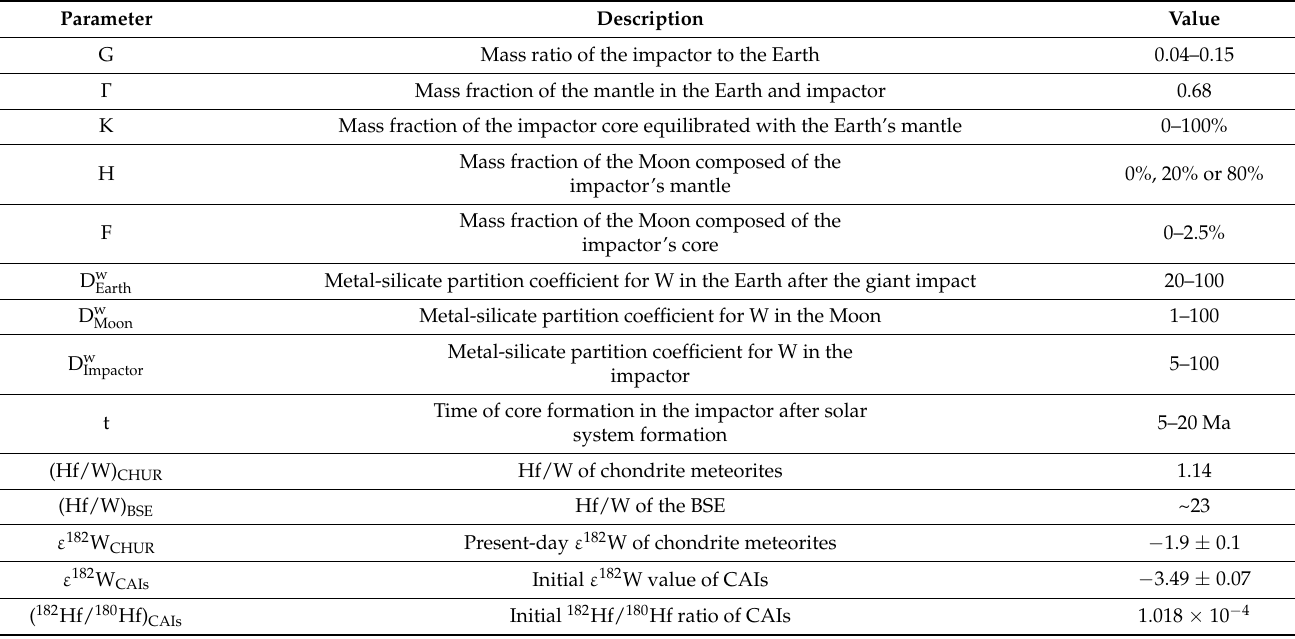
Table 3. Calculation parameters used in the simulation for the lunar ε 182 W value (modified after [15]).